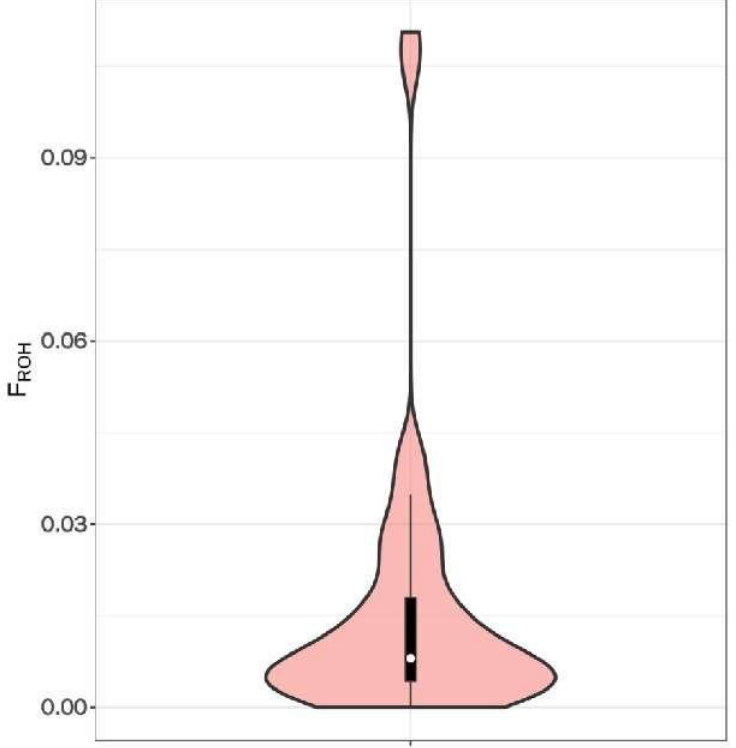
Figure 5. Distribution of the inbreeding coefficient froh based on Roh. Note: This violin chart is mainly used to show the distribution of data. The white dot in the center represents the median of the population FROH, and the upper and lower edges of the black box in the middle represent the upper and lower quartiles of the population FROH, respectively. The width of the violin chart indicates the probability density distribution of the population FROH. The wider part of the violin chart indicates that there are a larger number of samples at this level, and vice versa.